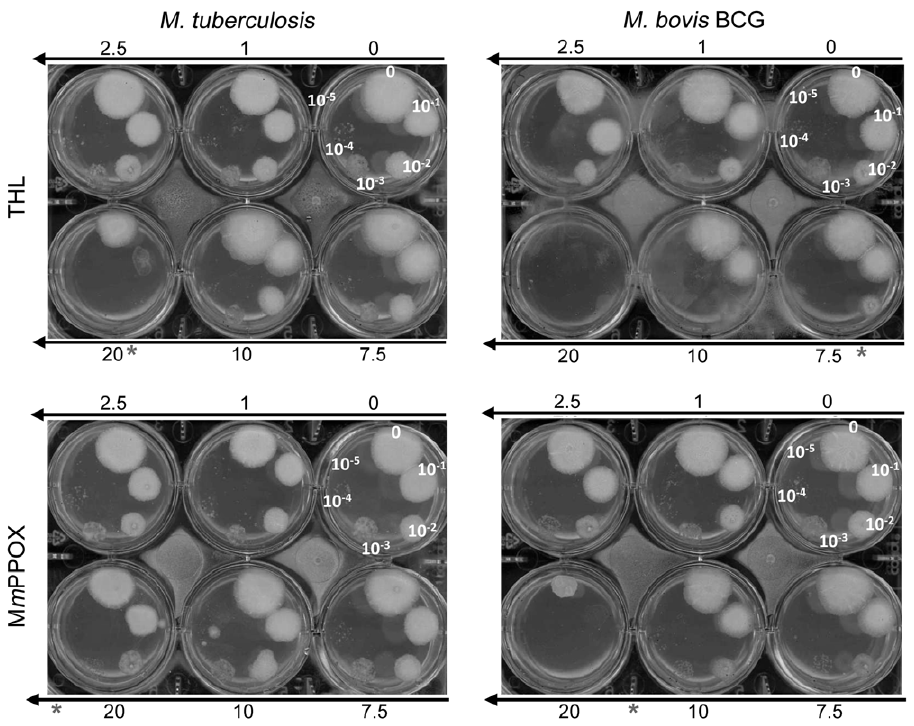
Figure 4. Antimycobacterial activity of M m PPOX and THL. Susceptibilities of M. tuberculosis were determined on solid medium with increasing inhibitor concentrations (1–20 m g/mL). Serial 10-fold dilutions (indicated on plates) of an actively growing culture were plated and incubated at 37 u C for 2–3 weeks. MIC were defined as the minimum concentration required to inhibit 99% of the growth. MIC against M. tuberculosis and M. bovis BCG are indicated with a star and estimated to be 20 and 7.5 m g/ml for THL and . 20 (around 25) and between 10–20 m g/mL for M m PPOX, respectively.